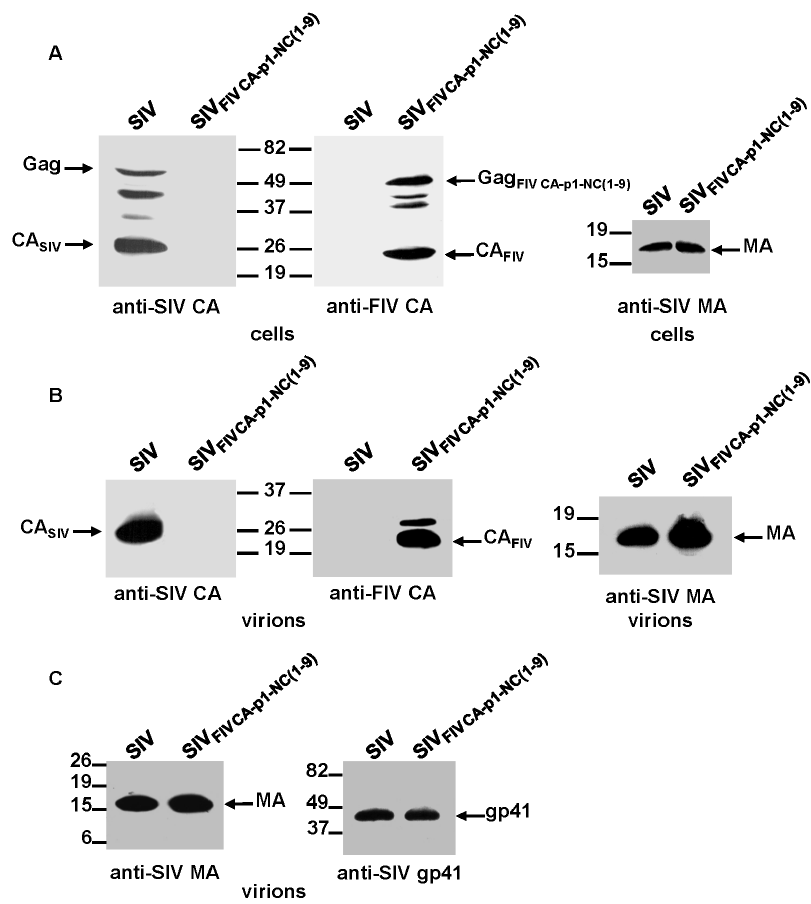
Figure 4. Analysis of particle production and Env incorporation into virions for SIV FIV CA-p1-NC(1–9) . 293T cells were transfected in parallel with wild-type SIV SMM-PBj and SIV FIV CA-p1-NC(1–9) proviral DNAs. Cell- (A) and virion-associated (B) proteins were detected by Western blotting with antibodies directed against the SIV MA, the SIV CA, and the FIV CA proteins. (C) Env incorporation into the wild-type SIV SMM-PBj and chimeric SIV FIV CA-p1-NC(1–9) virions was determined by probing with an anti-SIV gp41 MAb (right panel). Virions were normalized for their MA content (left panel). The positions of the wild-type and chimeric Gag precursors, as well as those of the mature SIV MA, SIV CA, FIV CA and SIV gp41 proteins are shown. Numbers indicate the positions of the molecular weight standards (in